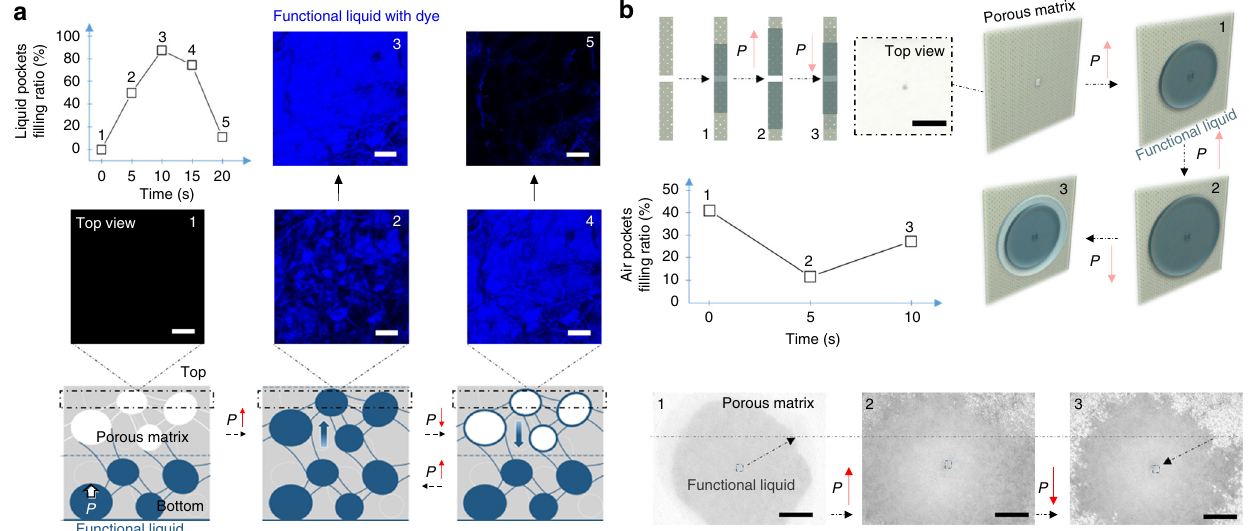
Fig. 2 Pressure-induced redistribution of air and liquid pockets. a Confocal microscopic studies. Functional liquid is silicone oil with dye DFSB-K175. The liquid pockets' fi lling ratio (determined by measuring the fl uorescence intensity in the air pockets) dynamically changes with the applied pressure over time. Confocal images of air pockets in their original un fi lled state (image 1), during their transition into liquid pockets by pressure-induced diffusion (image 2 → 3), and the recovery of the initial air- fi lled state after the removal of pressure (image 4 → 5). The corresponding schematics show the location of the images. Scale bar is 100 μ m. b Optical microscopy studies of dynamic distribution of air and liquid pockets under applied pressure. Functional liquid is Krytox ® 103. The cross-section view of the ADAPTS microchannel to illustrate the dynamic change of liquid pockets ’ distribution, and schematic of the changes of liquid pockets ’ distribution under varying pressures. The corresponding experimental images show the top view of the air/liquid pockets ’ distribution. Scale bar is 2 mm. The graph shows the air pockets' fi lling ratio and its change with the applied pressure over time (determined by measuring the area occupied by the air pockets that appear translucent in optical